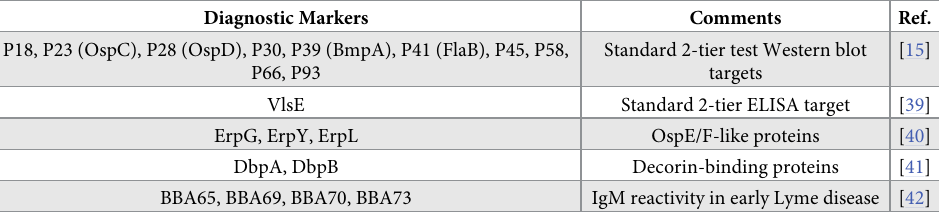
Table 1. Current and potential targets for LD